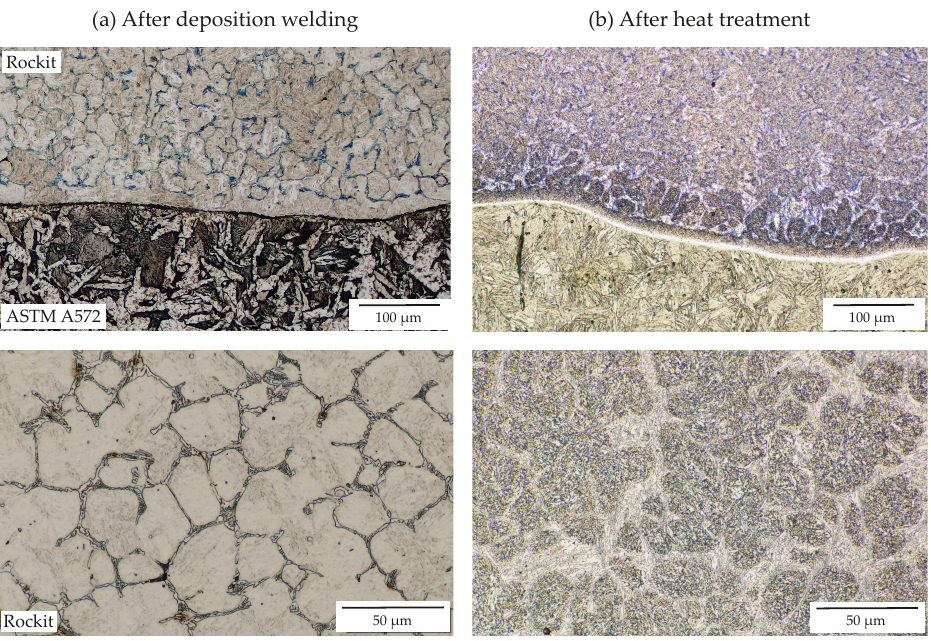
Figure 3. Micrographs of the transition zone: ( a ) after deposition welding; ( b ) after heat treatment (quenching and tempering); etched with 2% nitric acid solution + V2A acid solution.